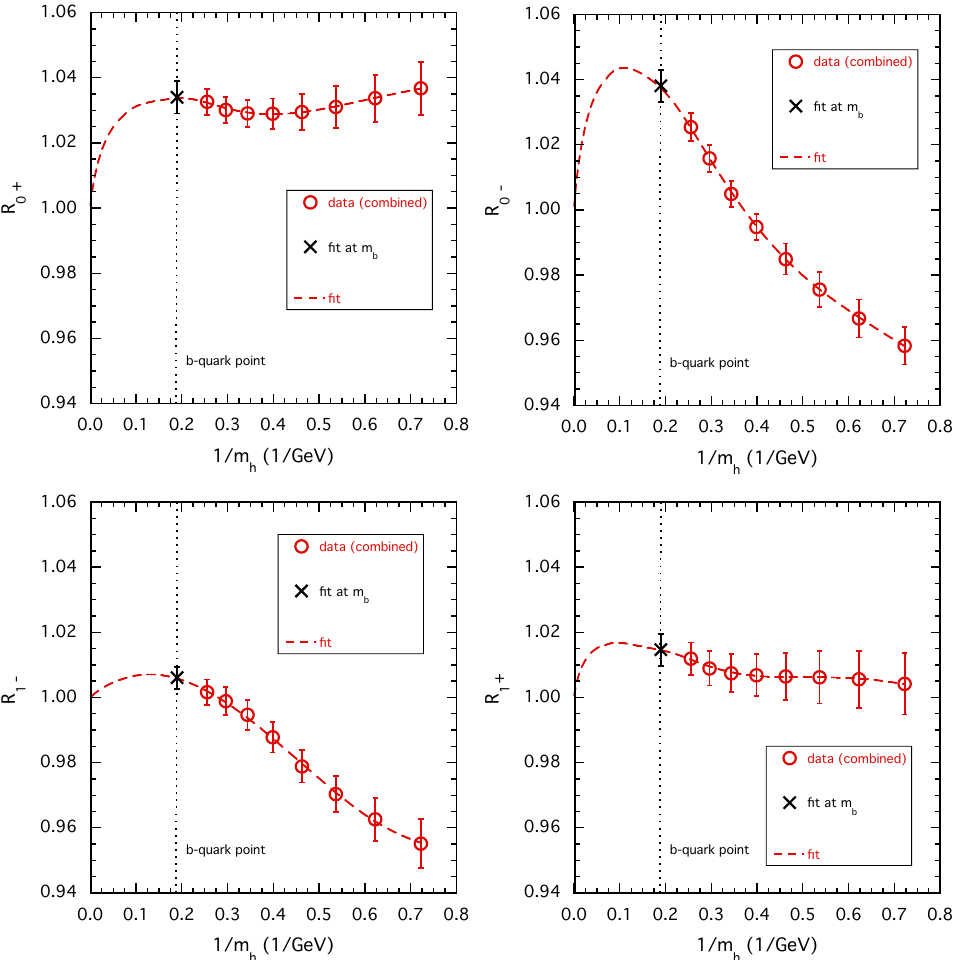
(left top panel), R (right top panel), R (left bottom Figure 8 . The susceptibility ratios R 0 + 0 − 1 − panel) and R (right bottom panel) after extrapolation to the physical pion point and to the 1 + continuum and infinite volume limits based on the combined fit (A.27) of the data corresponding to the two combinations ( r, − r ) and ( r, r ) of the Wilson r -parameters, versus the inverse heavy-quark mass 1 /m . The dashed lines are the results of the fitting procedure (A.29), described in the next h subsection, and the crosses represent the values of the ratios R at the physical b -quark point, shown j as a vertical dotted